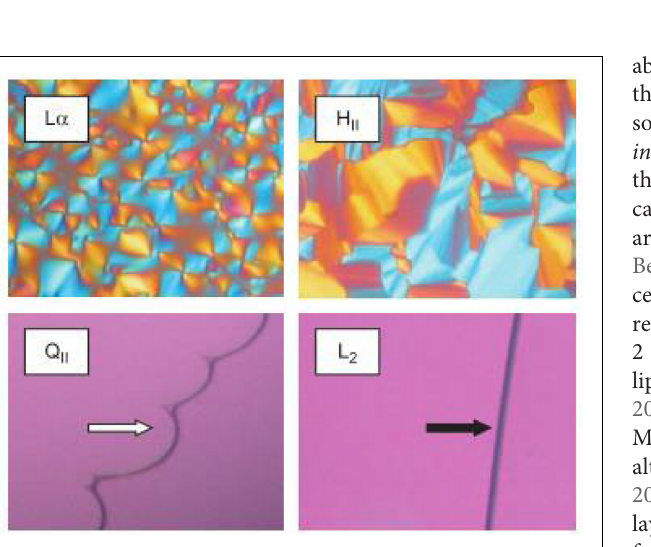
FIGURE 4 | Images of various LC mesophases captured using CPLM. The upper panels are examples of CPLM images of anisotropic mesophases like L α and H 2 phases show birefringence. The dark appearances on the bottom panels are due to the isotropic nature of the V 2 (called Q II in the original work this image is reproduced from) and L 2 phases. The V 2 and L 2 phases can be distinguished by their appearance at the lipid/water interface. Images were reproduced with permission from Boyd et al.